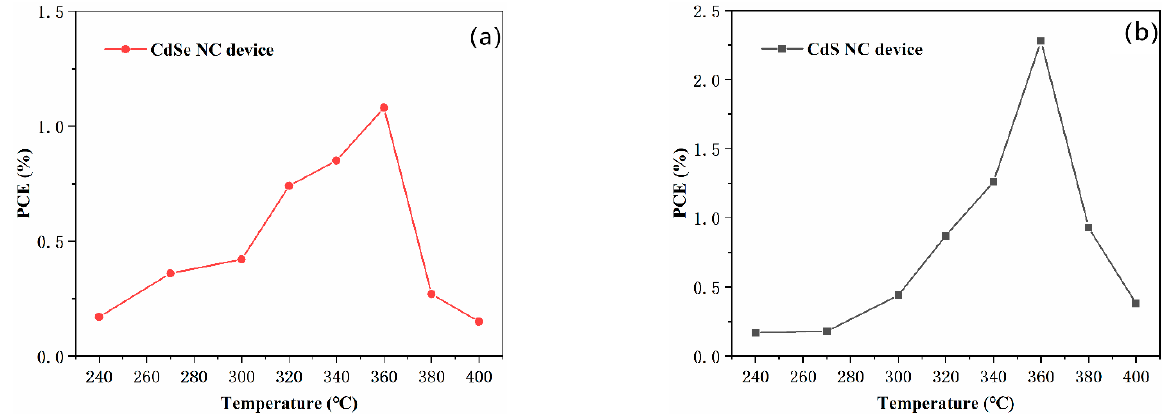
Table 2. Summarized performance of CdTe/CdS NC solar cells with different annealing temperatures (Figure 5b). Figure 6. Evolution of parameters PCE for ( a ) CdTe/CdSe NC devices ( b ) CdTe/CdS NC devices under different annealing temperatures. Table 1. Summarized performance of CdTe/CdSe NC solar cells with different annealing temperatures (Figure 5a). Annealing Temperature 340